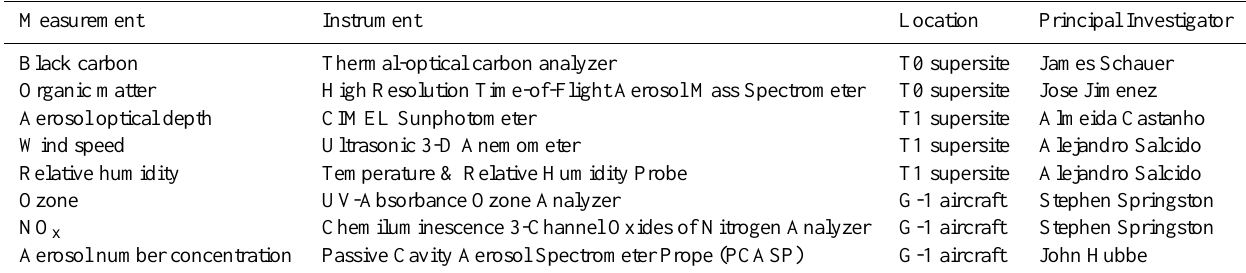
Table 3. Primary observations used in this